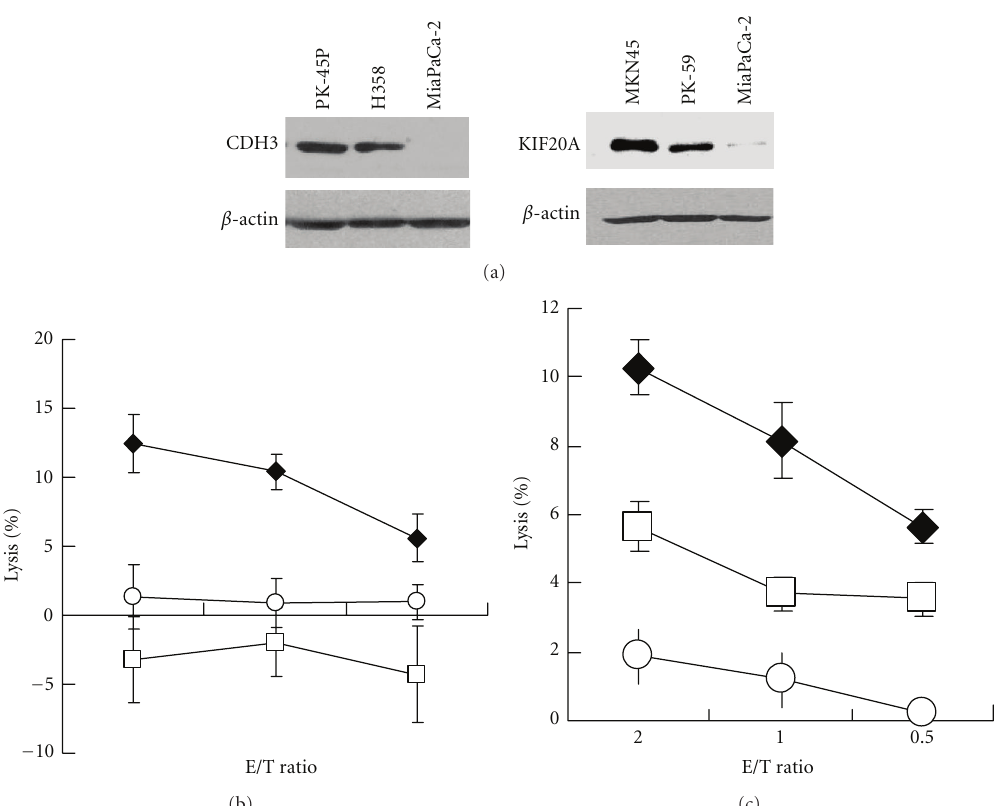
Figure 6: Cytotoxic activity against tumor cells expressing respective gene. (a) The expression of CDH3 and KIF20A protein in tumor cells used in cytotoxic assay. (b) Cytotoxic activity of CDH3-10-807 peptide-specific CTL clone against CDH3-expressing HLA-A ∗ 2402- positive PK-45P cells (closed diamond), CDH3-expressing HLA-A ∗ 2402-negative H358 cells (open square), or MiaPaCa-2 cells (open circle). Cytotoxicity against PK-45P cells was significantly higher than those against other cells. (c) Cytotoxic activity of KIF20A-10-66 peptide- specific CTL clone against KIF20A-expressing HLA-A ∗ 2402-positive MKN-45 cells (closed diamond), KIF20A-expressing HLA-A ∗ 2402- negative PK-59 cells (open square), or MiaPaCa-2 cells (open circle). Cytotoxicity against MKN-45 cells or PK-59 cells are significantly higher than that against MiaPaCa-2 cells, although cytotoxic activity against PK-59 cells was significantly lower compared with that against MKN- 45 cells. E/T ratio, e ff ector cell (CTL clone)/target cell (tumor cell) ratio. Similar results were obtained in three independent experiments using same CTL clone and in independent experiments using other CTL